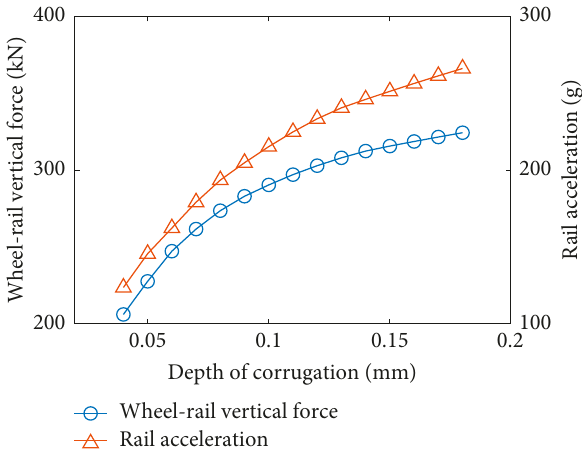
Figure 4: Effect of rail corrugation depth on wheel-rail interaction.